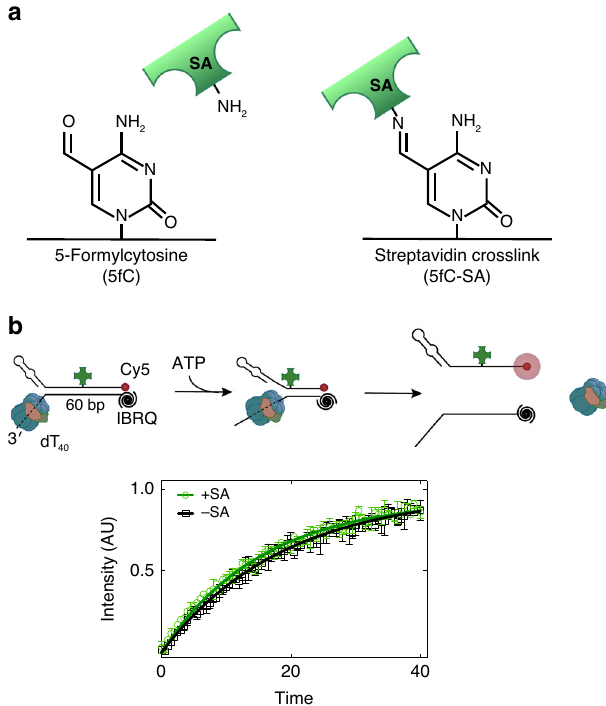
Fig. 7 CMG bypasses a protein directly crosslinked to the excluded strand with no detectable stalling. a 5-formyl-cytosine-modi fi ed oligonucleotide covalently crosslinks to streptavidin through primary amines. b Single-turnover CMG-mediated unwinding of fork DNA substrates with and without a 5fC-streptavidin cross-link. The 5 ′ tail of the DNA substrate contained d(GGCA) 10 sequence, which generates secondary structures and prevents helicase pausing at the fork junction. Fork DNA included 60-bp duplex region and were modi fi ed with Cy5 at the 3 ′ end of the lagging-strand template and Iowa Black RQ (IBRQ) dark quencher at the 5 ′ end of the leading-strand template. Separation of the complementary strands by CMG leads to fl uorescence increase, a proxy for DNA unwinding. CMG unwinds 5fC-streptavidin-crosslinked and non- crosslinked substrates with the same kinetics. Data represent mean ± SD ( n = 3 independent experiments). Solid lines represent fi ts to Eq. (2) (Methods). Source data are provided as a Source Data fi